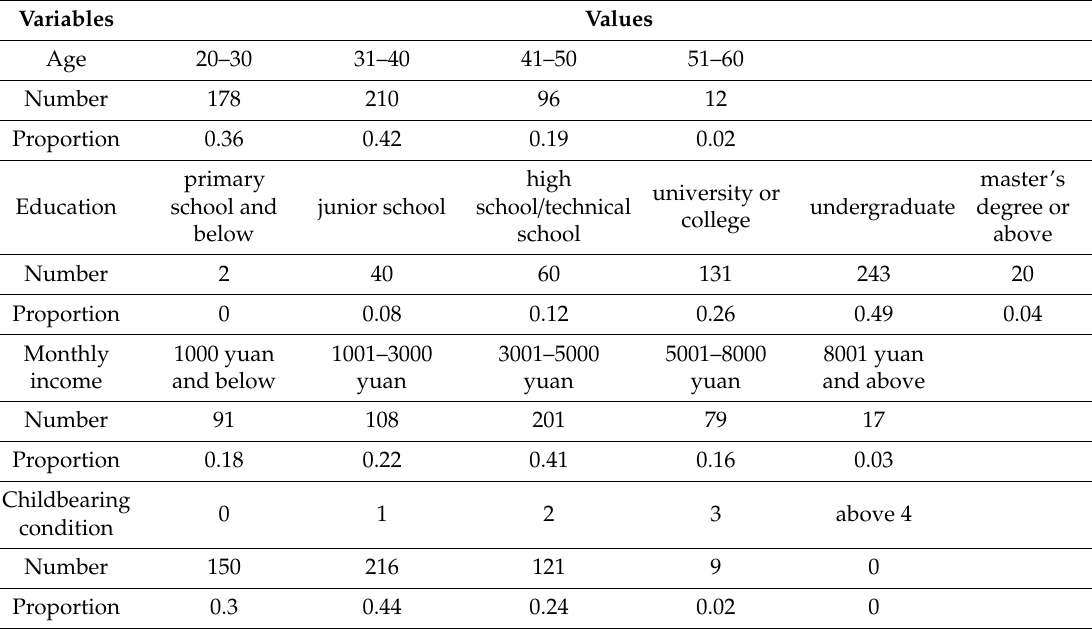
Table 1. Demographic variables ( n =